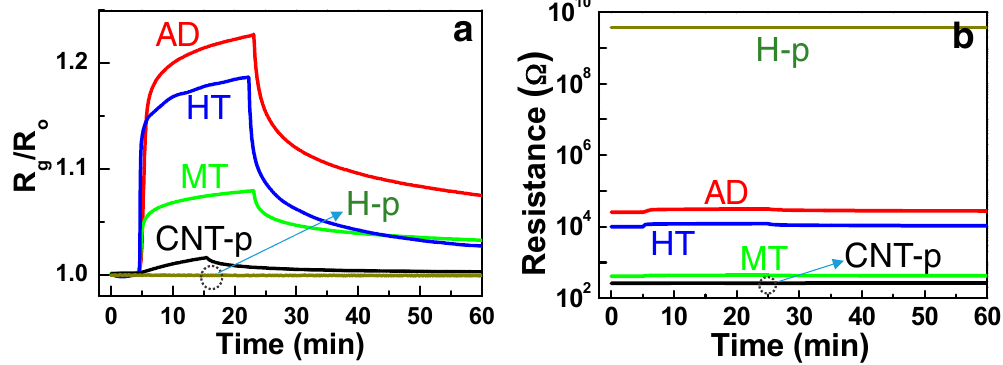
Figure 5. ( a ) Sensor response-recovery characteristics of AD, MT, and HT structures to 500 ppm ammonia at room temperature (RT). The responses of the composites showed a synergetic effect compared with pure hematite (H-p) and pure SWCNT (CNT-p). ( b ) The same presented by the change in resistances.